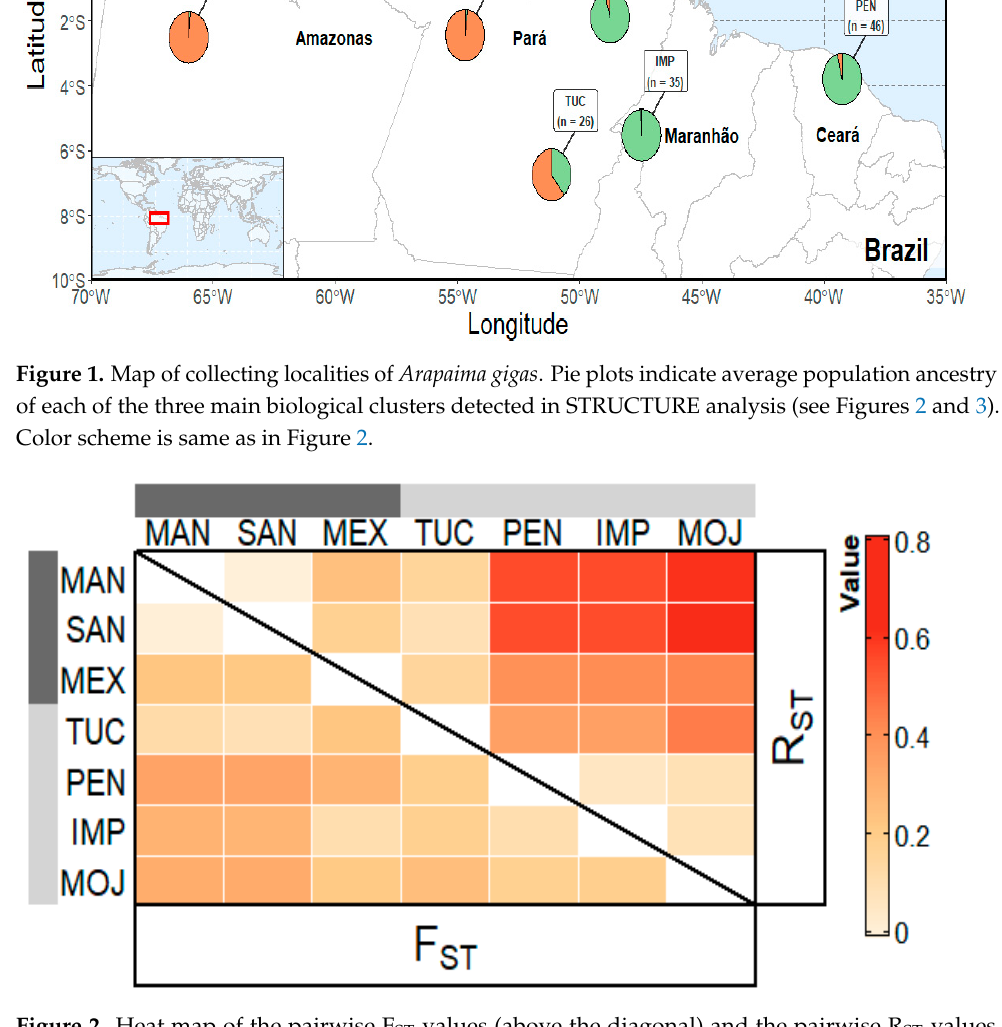
Figure 3. Standard population structure of three wild and four farmed populations of Arapaima gigas . The analysis based on 12 ‐ loci microsatellite markers, supported by STRUCTURE, indicated the existence of two groups (K = 2). MAM—Mamirauá; SAN—Santarém; MEX—Mexiana; TUC— Tucumã; PEN—Pentecostes; IMP—Imperatriz; MOJ—Moju. The samplings were preserved in 70% ethanol (Merck KGaA, Darmstadt, Germany) and posteriorly stored in − 20 °C. Total genomic DNA was extracted from the digested tissue in proteinase K solution/Sodium Dodecyl Sulfate (SDS) (Thermo Scientific, Wal ‐ tham, Massachusetts, United States) and purified in Phenol/Chloroform (Invitrogen, Wal ‐ tham, Massachusetts, United States), followed by precipitation in Isopropanol (Merck KGaA, Darmstadt, Germany) [12]. The DNA concentration was measured in the NanoDrop ND1000 spectrophotometer (Thermo Scientific, Waltham, Massachusetts, United States). 2.3. Amplification and Genotyping of the Microsatellites